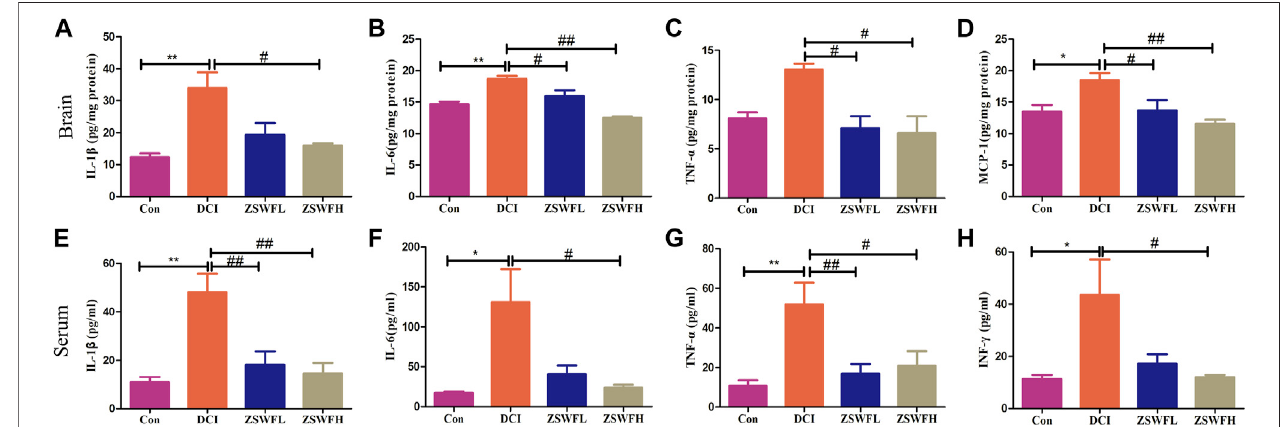
FIGURE 2 | ZSWF suppressed hippocampal and peripheral in fl ammation in DCI mice. (A) IL-1 β contents in the hippocampus, (B) IL-6 contents in the hippocampus, (C) TNF- α contents in the hippocampus, (D) MCP-1 contents in the hippocampus, (E) IL-1 β levels in the serum, (F) IL-6 levels in the serum, (G) TNF- α levels in the serum, (H) INF- γ levels in the serum. All data were expressed as mean ± SD ( n = 6). One-way ANOVA was used to compare statistical differences between groups. ** p < 0.01, * p < 0.05 vs. Con group, ## p < 0.01, # p < 0.05 vs. DCI